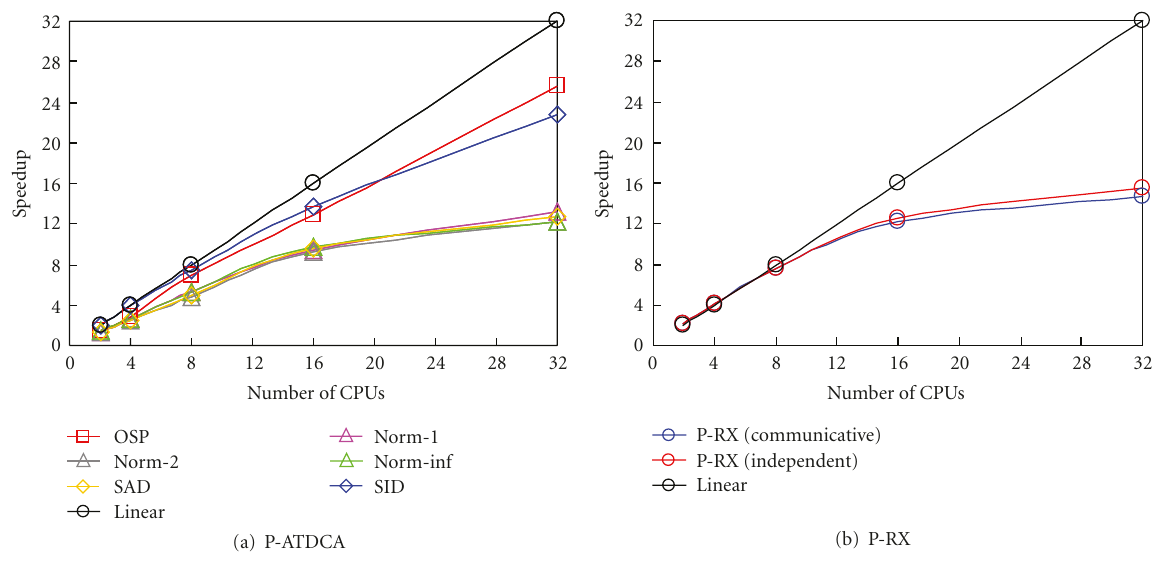
Figure 14: Speedups achieved by (a) P-ATDCA (using di ff erent distance measures) and (b) P-RX (communicative and independent versions) on the Thunderhead Beowulf cluster at NASA’s Goddard Space Flight Center in Maryland.